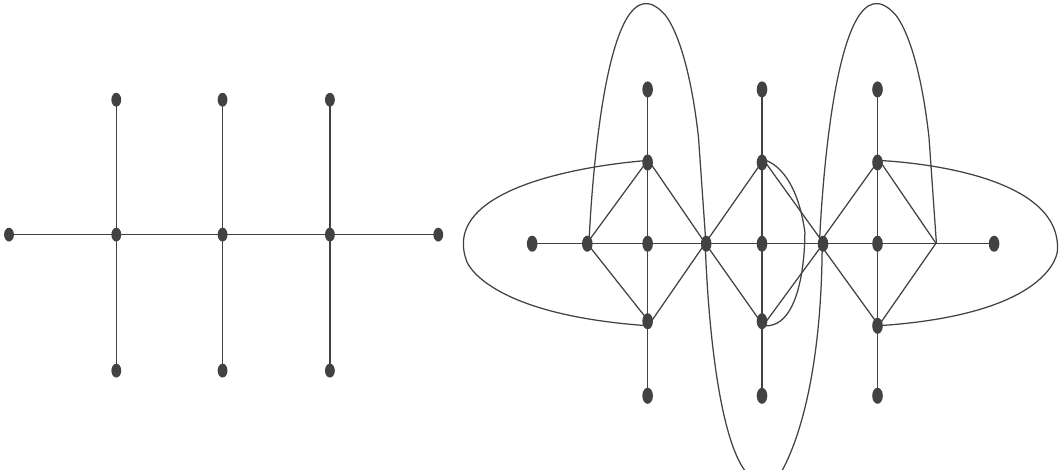
Figure 2: Alkane (C